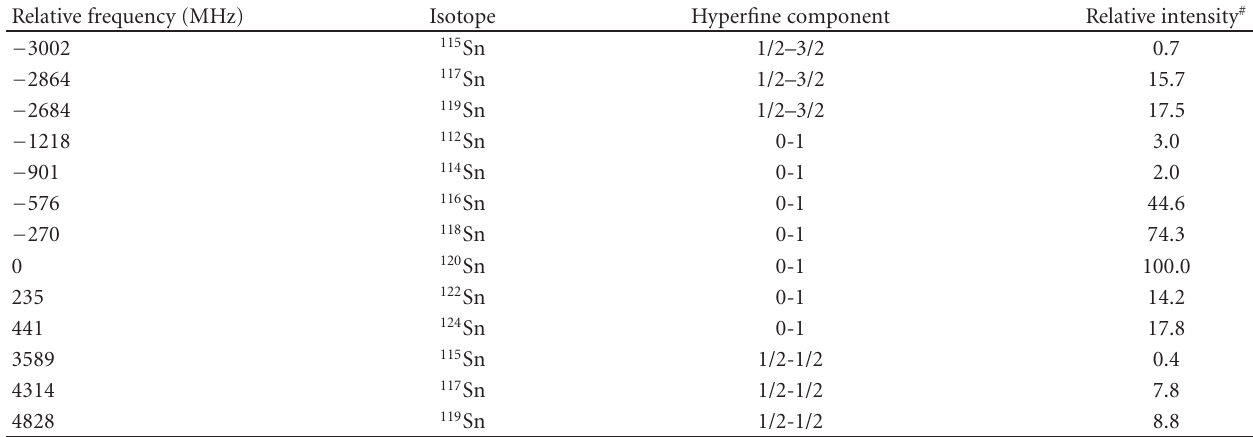
) (286.3317nm) transition. 1